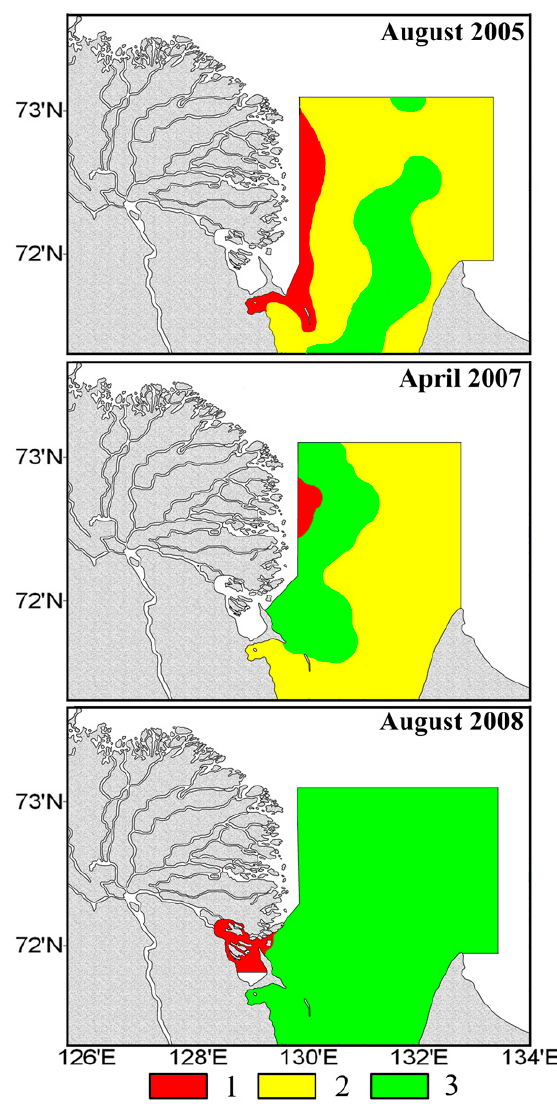
Fig. 2. Stratification of water column of the Buor-Khaya Gulf according to Hanssen-Rattri index: 1 – intermixed waters, 2 – medium-stratified, 3 – stratified.